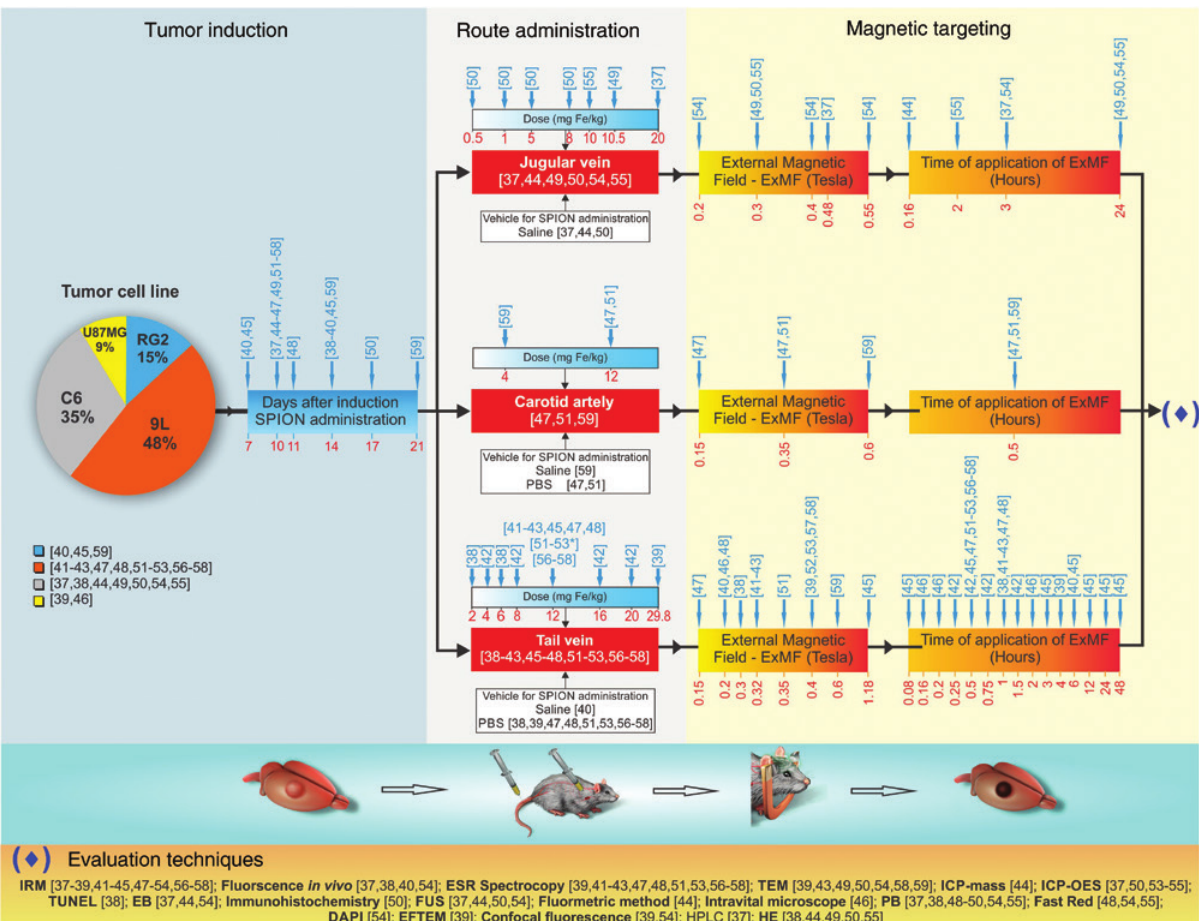
Figure 3: Experimental designs of magnetic targeting process used in the studies selected for the review. *Number of repetitions of ExMF. Studies not mentioned in this figure did not present any of the data items